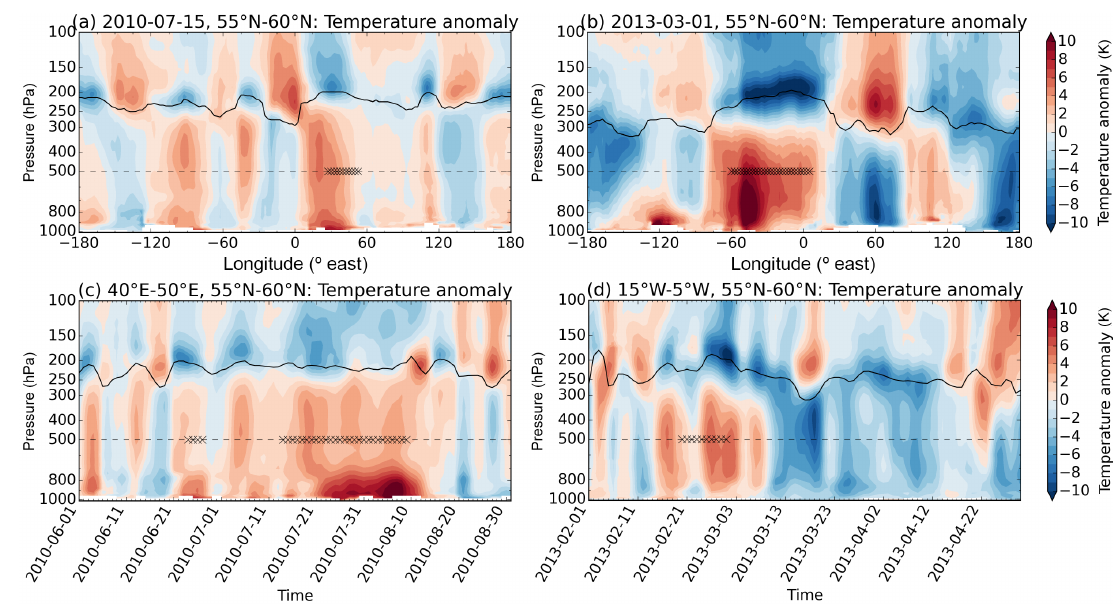
Figure 7. Same layout as Fig. 6 but for temperature